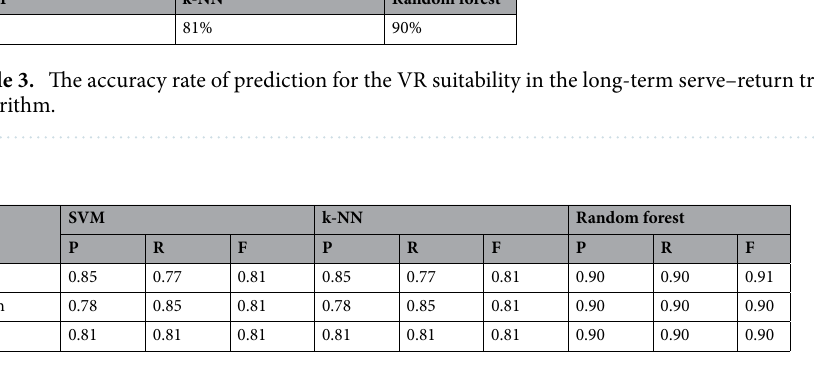
Table 4. The precision, recall rate, and F-values of prediction for the VR suitability in the long-term serve– return training in each algorithm. P precision, R recall rate, F F value.